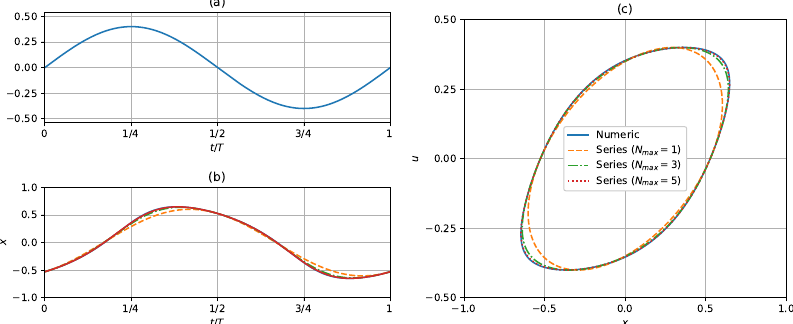
Figure 1. Comparison of system behavior predictions using numerical and analytical solutions (57) ( N max = 1,3,5) for ω = 0.5, A = 0.4 and φ = 0 ( T = 2 π / ω ), with g 2,0 = − 1.317. ( a ) u vs. τ / T , ( b ) x vs. τ / T , and ( c ) phase plane ( x , u )